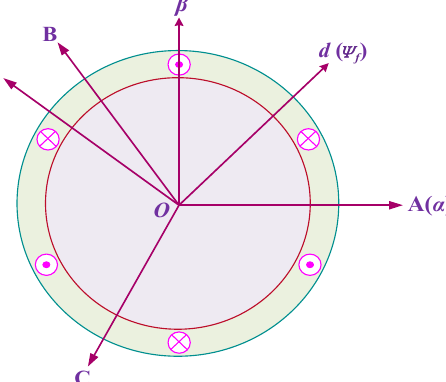
Figure 2. Space position map of three different coordinate systems.